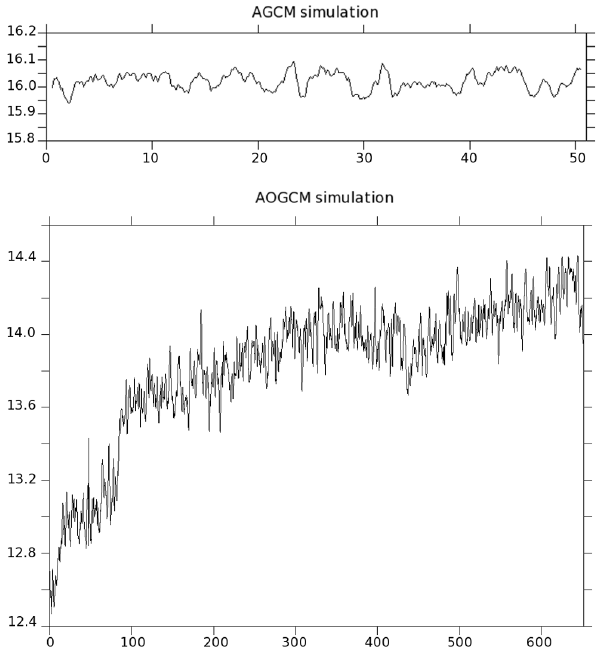
Fig. 6. Evolution of the globally averaged 2m temperature for the AGCM and AOGCM, expressed in degrees Celsius.